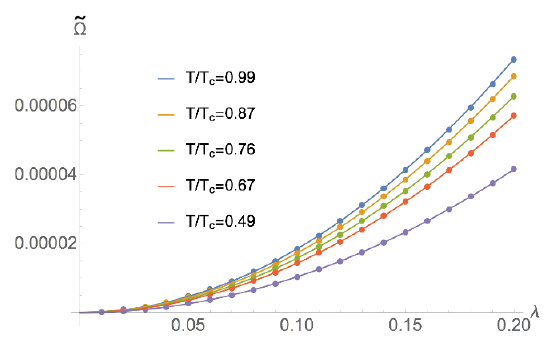
Figure 14 . Phase relaxation (cid:10) as a function of the explicit breaking parameter (cid:21) . The solid lines are (cid:12)ts to the data of the form (cid:10) = a + b(cid:21) c , for which we obtain a (cid:24) 10 (cid:0) 8 , b 2 (1 (cid:1) 10 (cid:0) 3 ; 1 : 8 (cid:1) 10 (cid:0) 3 ), c = 2 (cid:6) 10 (cid:0) 4